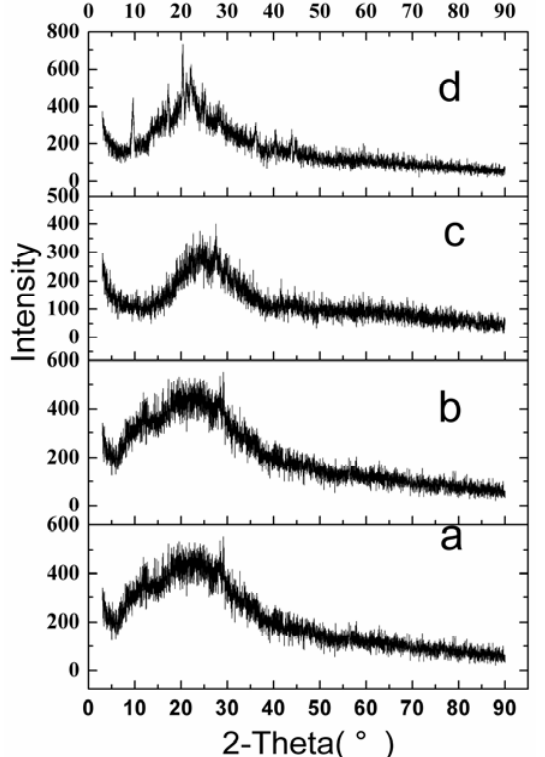
Figure 5. X-ray diffraction (XRD) patterns of raw VLBT and VLBT-loaded nanoparticles.